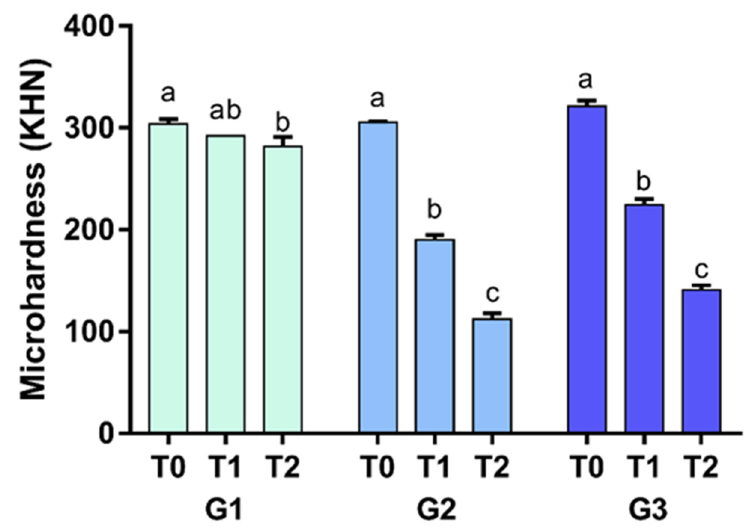
Figure 3. The mean ± standard deviation of the microhardness subjected to two-way analysis of variance for repeated measurements according to the periods for the groups tested. Different lowercase letters indicate an intragroup statistically significant difference.